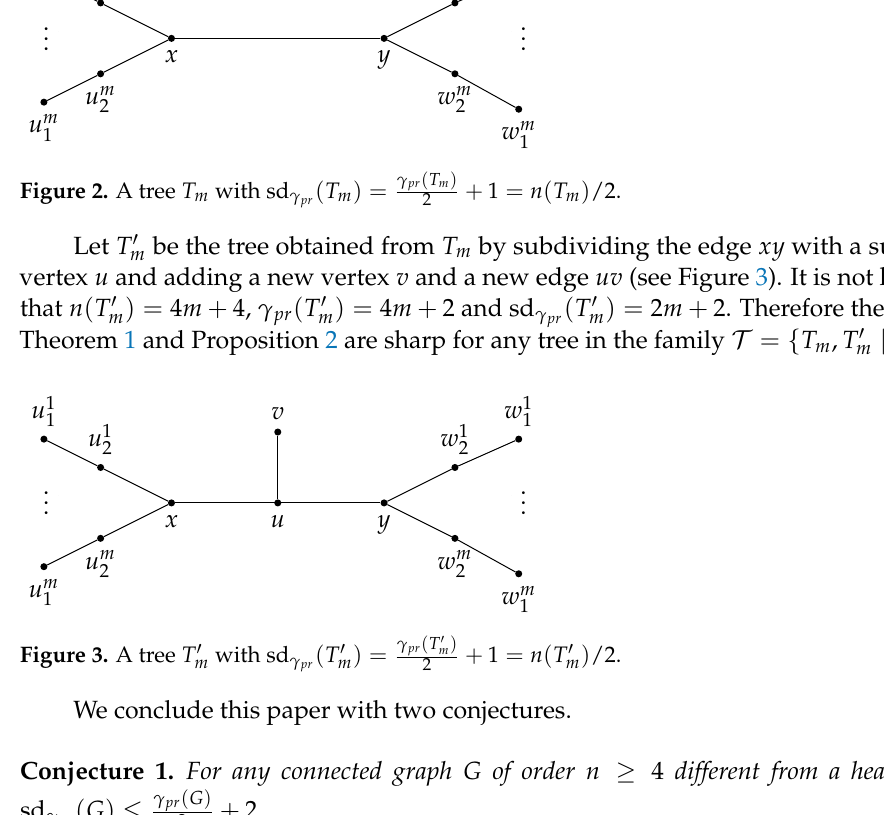
Figure 3. A tree T (cid:48) m with sd γ